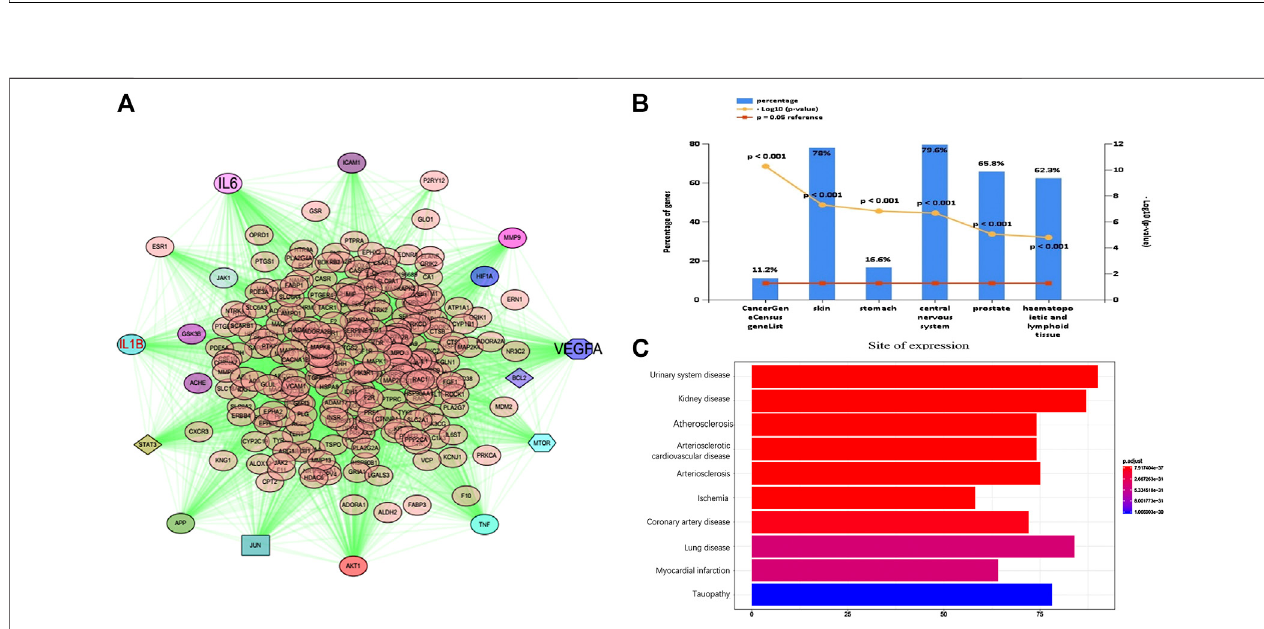
FIGURE 3 | PPI network and disease analysis of intersecting target of TQHXD. (A) PPI network of 265 common targets. (B,C) Clinical synopsis phenotypic terms.